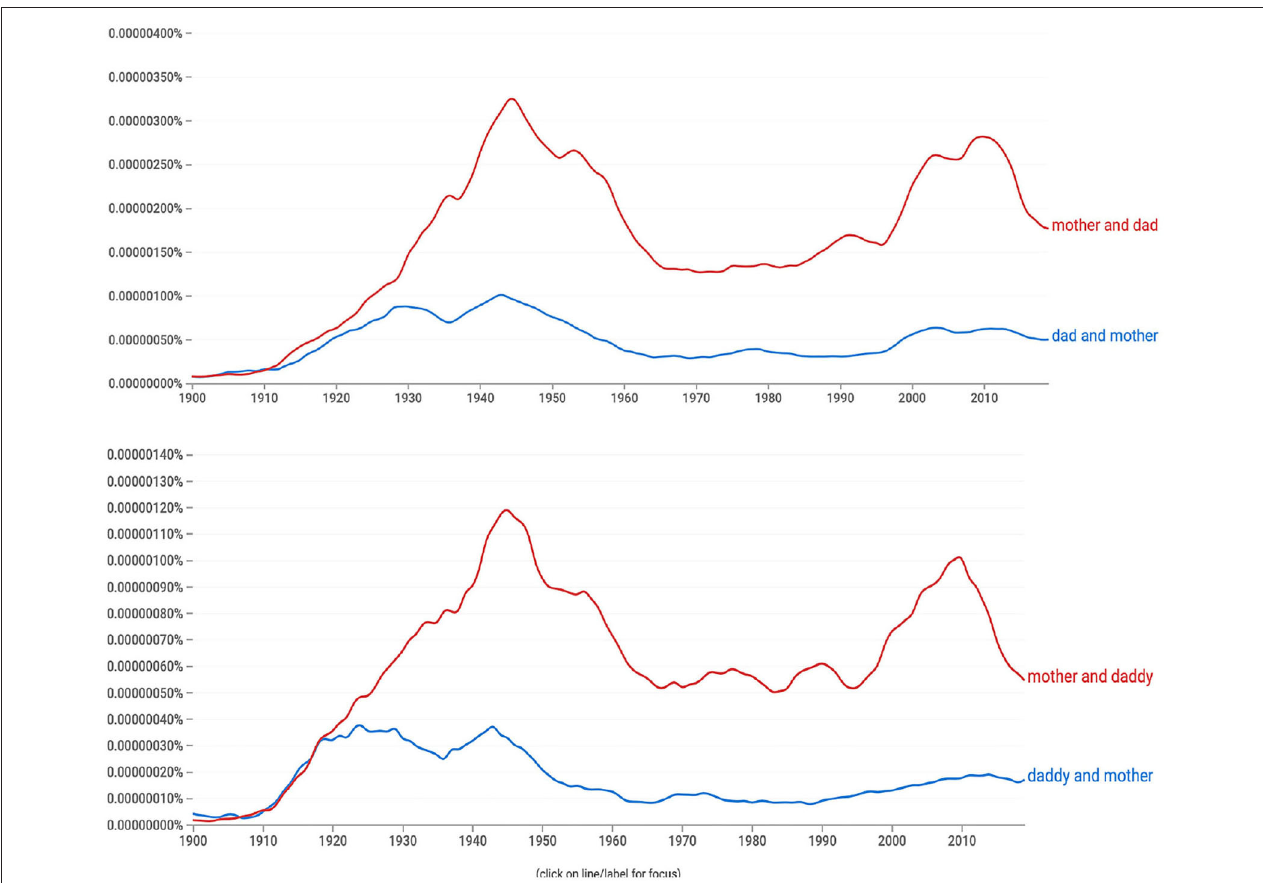
FIGURE 5 | The frequencies of individual terms: mother was two orders of magnitude more frequent than daddy or dad during the period when mother and daddy and mother and dad emerged (see this figure, 1900–1950).